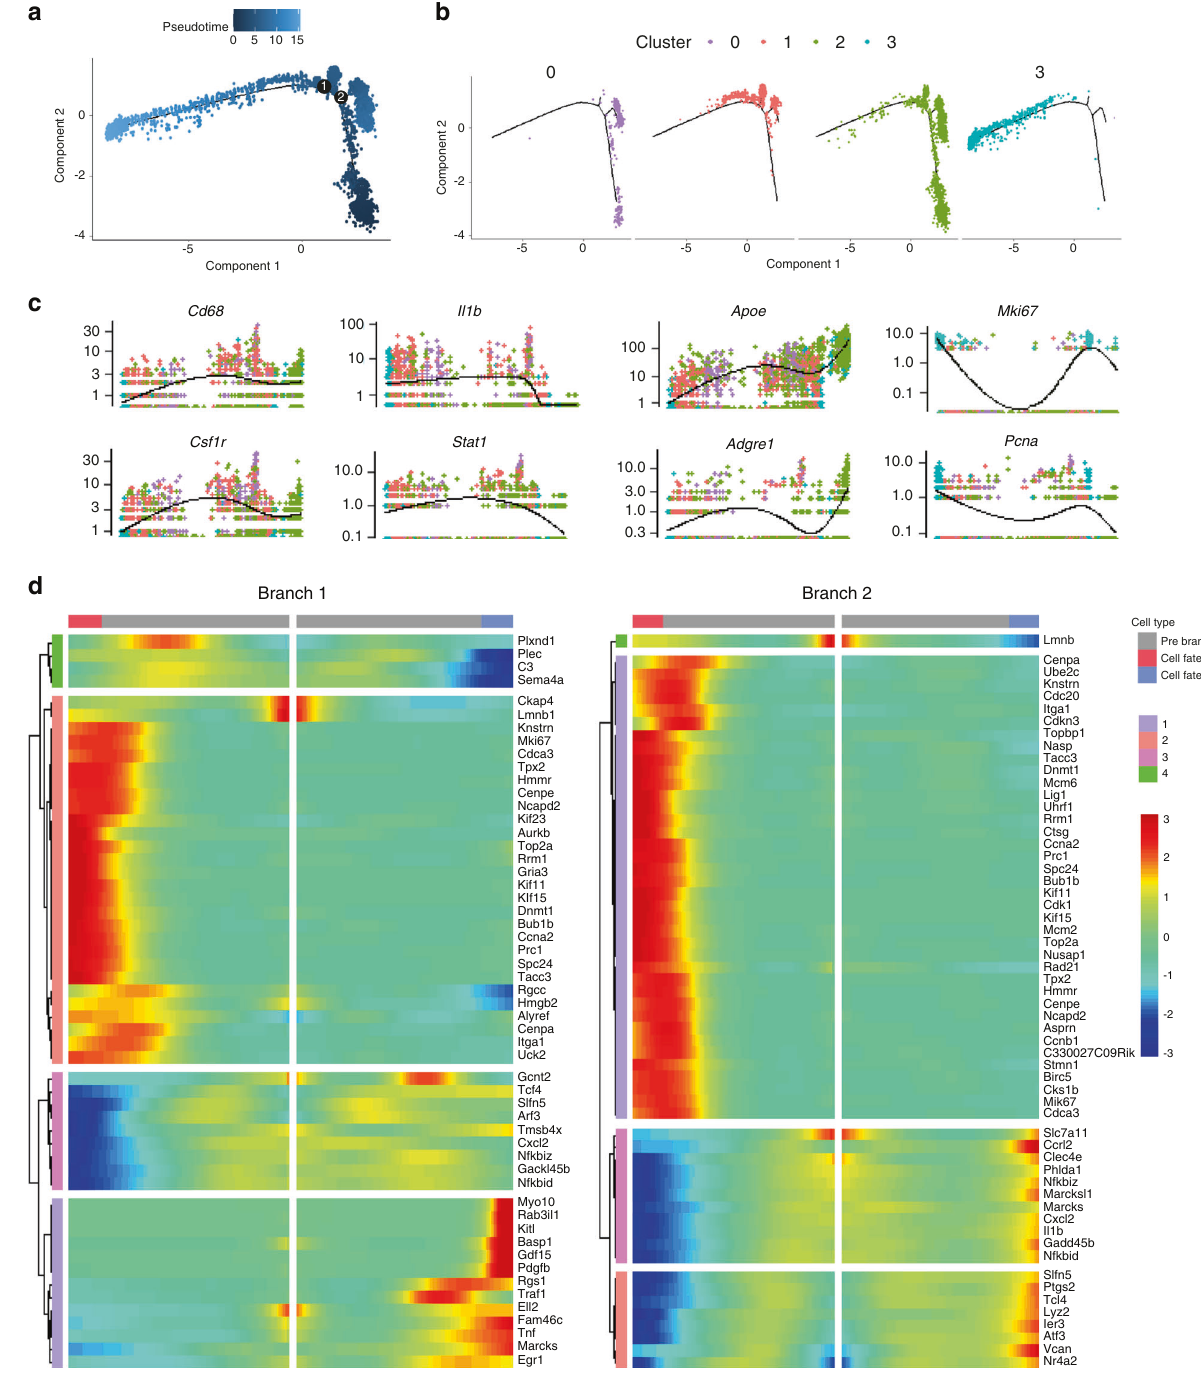
Fig. 4 Pseudotime analysis of monocyte/macrophage population. a Trajectory order of the monocyte/macrophage populations by pseudotime value. b Distribution of monocytes/macrophages on the developmental tree by clusters. c Cluster-de fi ned monocyte/ macrophage marker gene expression of different subclusters. d Clustered heatmap of differential genes at two trajectory branch points ( P < 1.0 − the higher proportion of activated macrophages in ABM led to the expression of Osm in ABM-derived macrophage was signi fi cantly increased expression of Osm , which subsequently regulate the higher than other tissues (Fig. 6b, c). This observation was further osteogenic and adipogenic differentiation of MSCs. con fi rmed by qRT-PCR analysis and enzyme-linked immunosor- bent assay (ELISA) (Fig. 6d, e). Osm is a regulatory cytokine considered to be secreted by the classically polarized macrophages. 27,28 Among the four monocyte/ macrophage subclusters, we found that Osm was mainly expressed in cluster 1 (Fig. 6f, g). Therefore, we supposed that